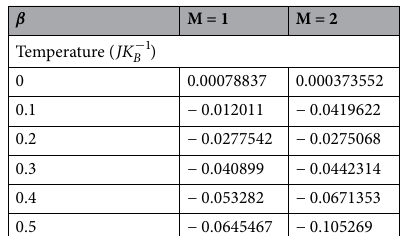
Figure 6. Variation of total energy ( µ ) with respect to the lattice vector k for ( a ) β 0.5 (blue line), ( c ) β ( b ) β = confinement. Here, the magnitude of physical parameters: γ 0 2 / 9 . E = −